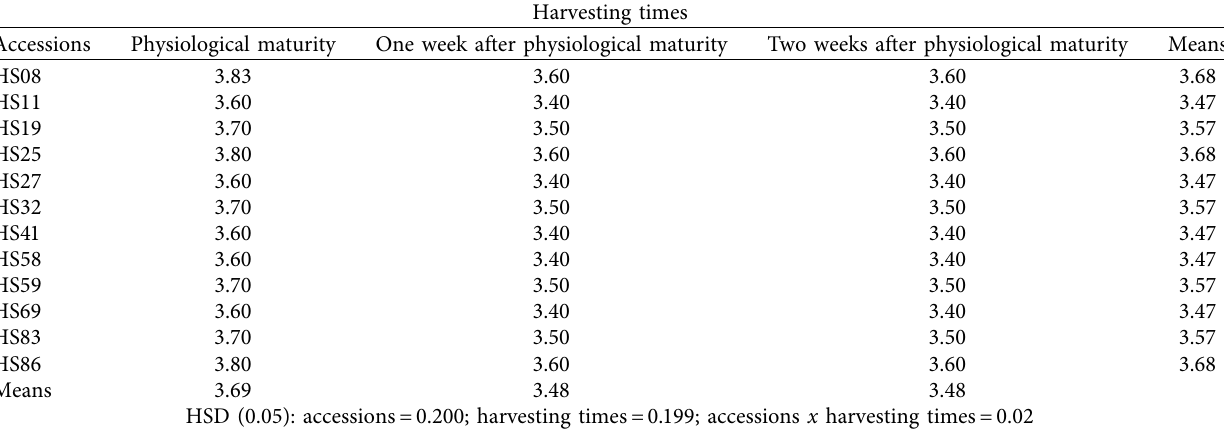
Table 5: Interactive effects of harvesting times x accessions on the seed geometric mean diameter (mm) of roselle. Harvesting times